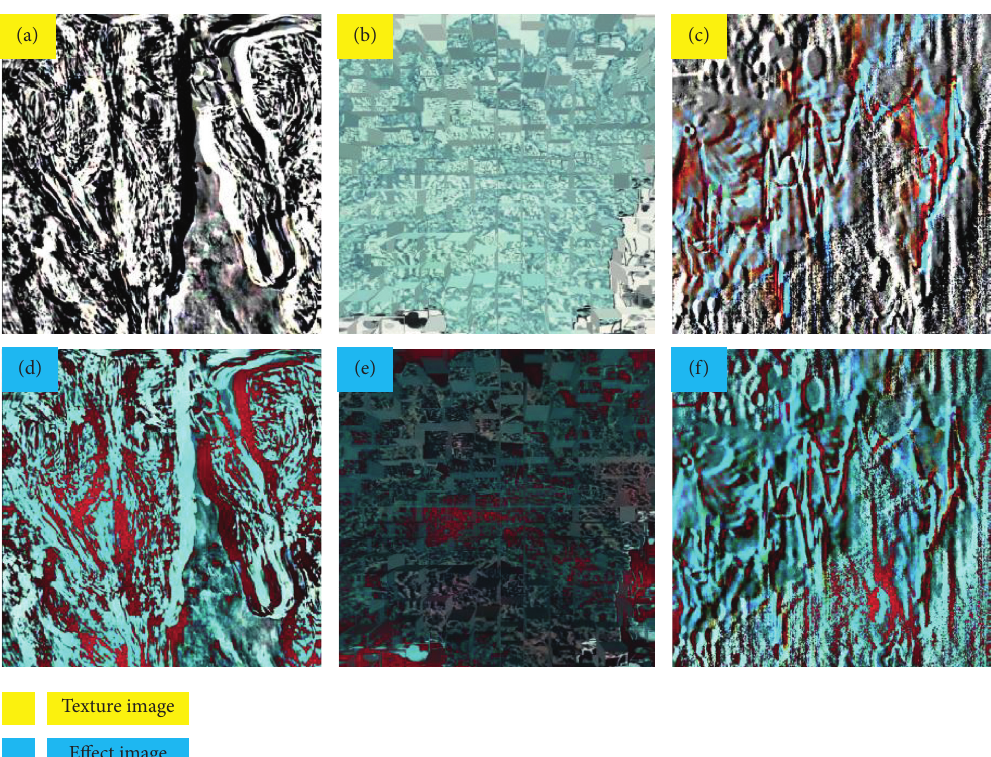
Figure 7: Synthetic parameters and synthetic effects of different texture